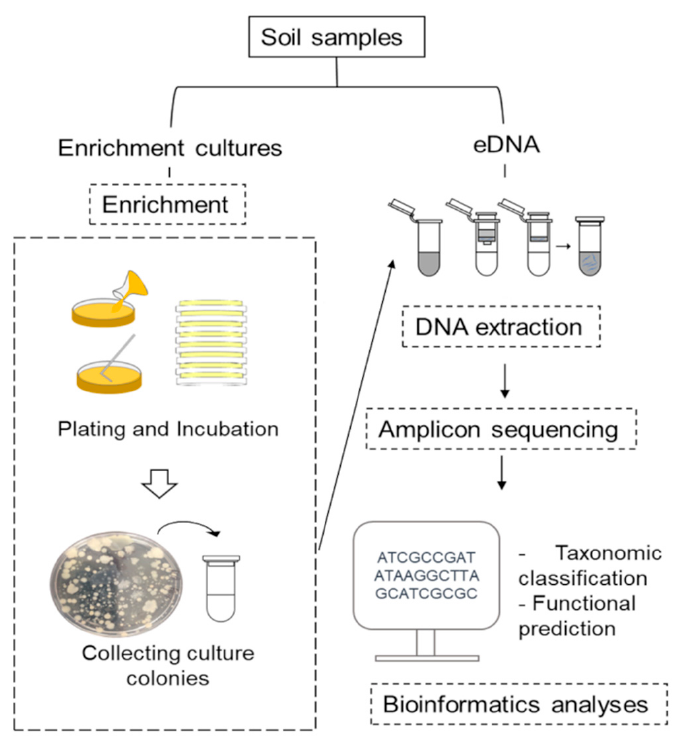
Figure 1. Workflow of amplicon sequencing based on enrichment culture vs eDNA.